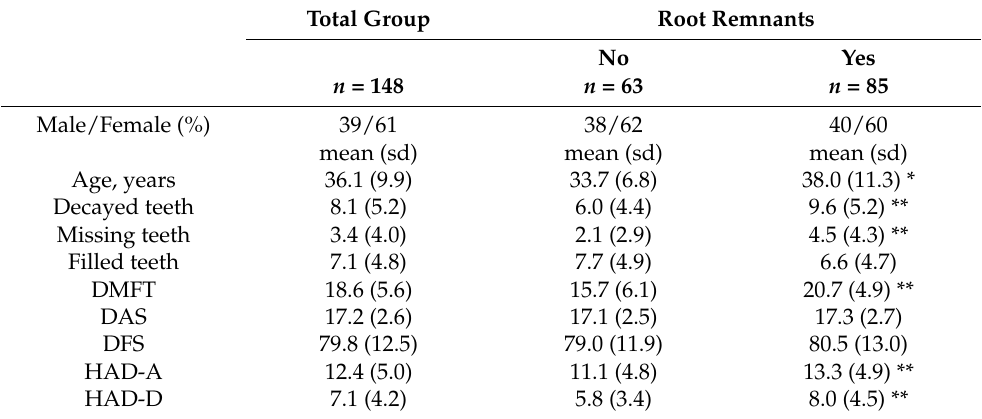
Table 1. Characteristics of adult patients attending DFRTC # referred for dental anxiety [25]. Age, gender distribution, dental status (Decayed Missing Filled Teeth (DMFT)), dental anxiety (Dental Anxiety Scale (DAS), Dental Fear Survey (DFS)) and general anxiety (HAD-A) and depression (HAD-D) for the total group and a comparison between subjects without root remnants and with root